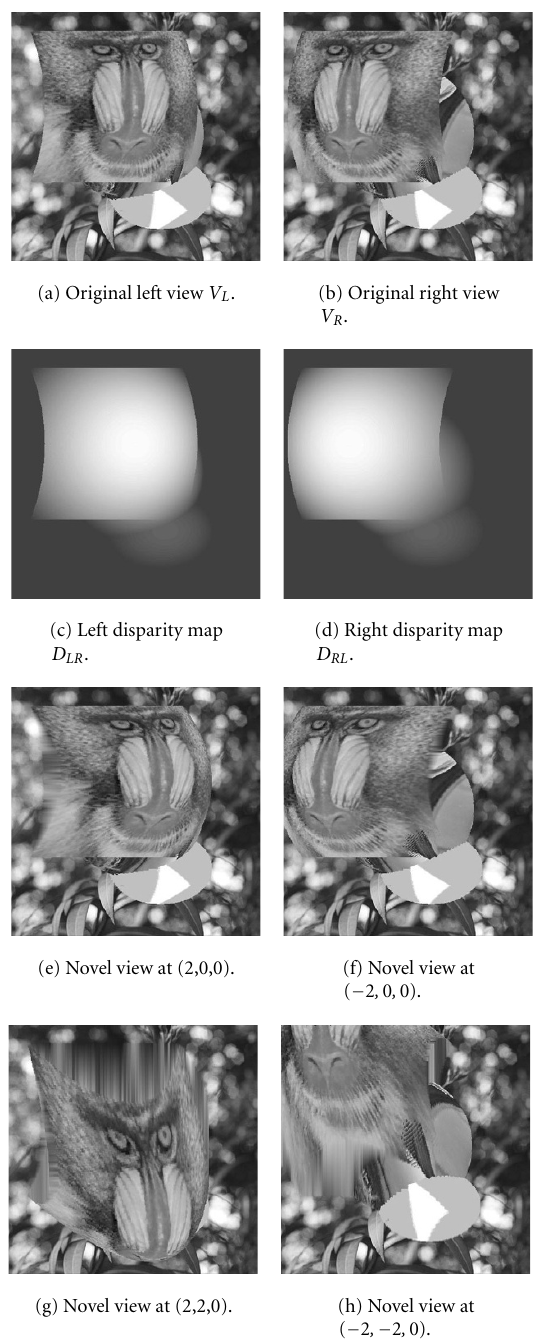
Figure 16: Novel views at di ff erence poses reconstructed from the synthetic stereo pair (a) and (b) by our multi-step algorithm based on the ground-truth disparity maps (c) and (d). It reveals the in- evitable problem of the current approach that some parts of the 3D scene may be visible in the desired novel view but they are not present in the stereo pair we have.